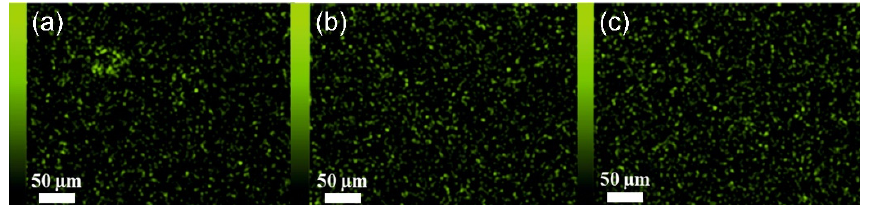
Figure 7. Surface of membranes containing ZIF-8. Mapped Zn; ( a ) PEBAX 2533 + 2 wt% ZIF-8, ( b ) PEBAX 2533 + 5 wt% ZIF-8, ( c ) PEBAX 2533 + 10 wt% ZIF-8.